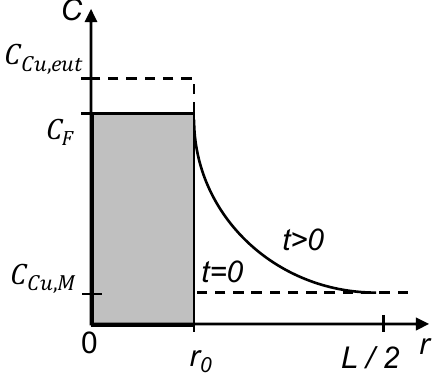
Figure 9. Schematic representation of one-dimensional planar particle half-geometry and the diffusion field; C Cu,eut , C Cu,M , and C F are the Cu concentrations in the Al 2 Cu particle, alloy matrix, and the interface, respectively.